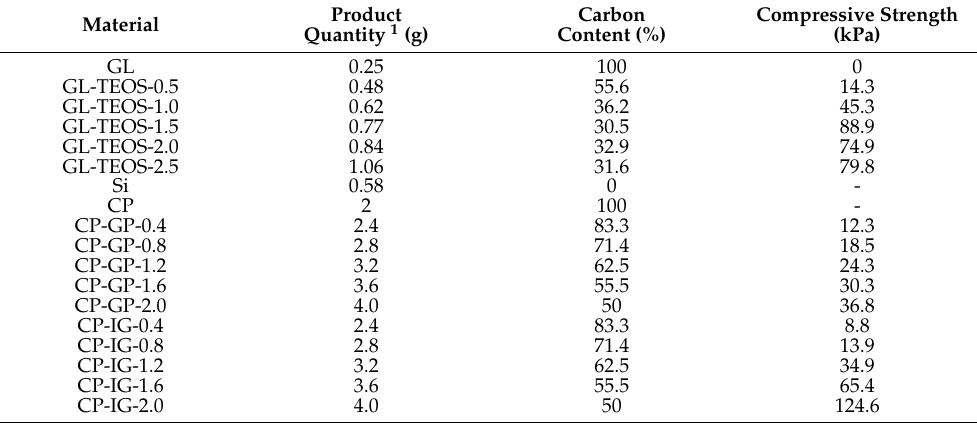
Table 1. Comparison of the product quantity, theoretical carbon content, and compressive strength of different carbon materials.